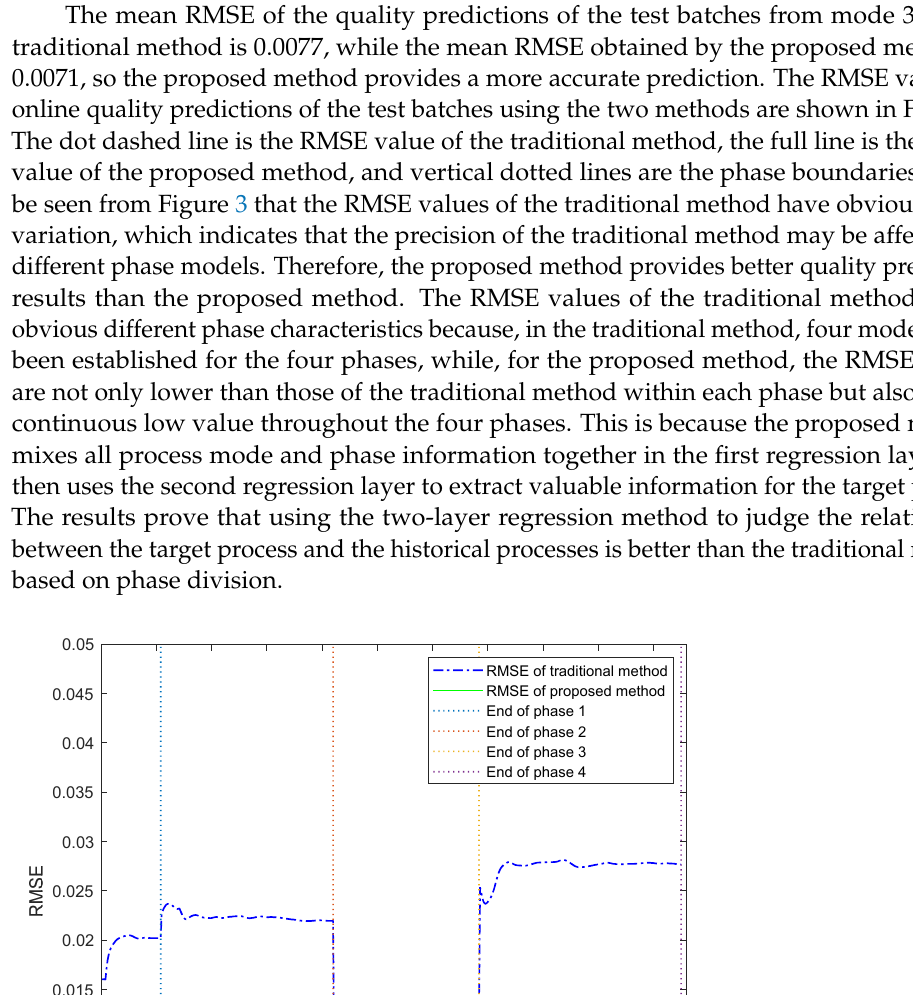
Figure 4. Online quality prediction results of one test batch. The monitoring results of the four phases of one normal test batch from mode 3 are shown in Figures 5, 6, 7 and 8, respectively. This batch, which has some fluctuation, may be identified as anormal batch by the traditional method, and false alarm will occur due to the process fluctuation. While, by the propose method, this normal batch can be nor- mally monitored. The details are as follows: In Figure 5 and 6, it can be seen that both T 2 and SPE of the proposed method and the traditional method do not exceed the control limits in the injection phase and the packing-holding phase. In Figure 7, it can be seen that, in the plasticizing phase, T 2 and SPE of the proposed method do not exceed their respec- tive control limits, while, for the traditional method, although T 2 does not exceed its con- trol limit, there is an obvious period at the beginning of the phase during which the SPE value exceeds its control limit. In fact, the fluctuation of this batch is caused by the transi- tion between the packing-holding phase and the plasticizing phase. During the transition,